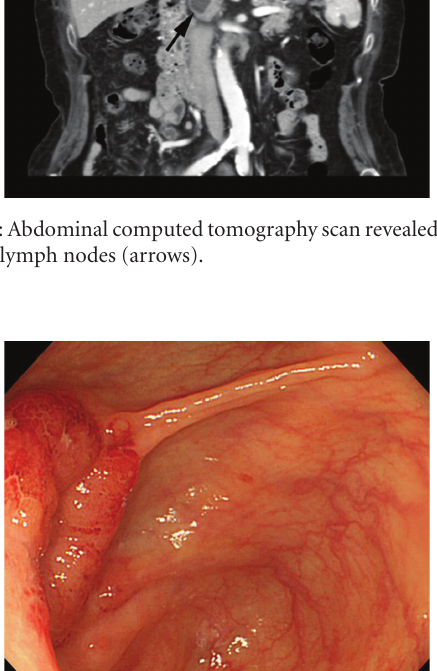
Figure 4: Histopathological image of the nodule (Figure 3) showing epithelioid granulomas with multinucleated giant cells (hematoxylin and eosin staining, ×